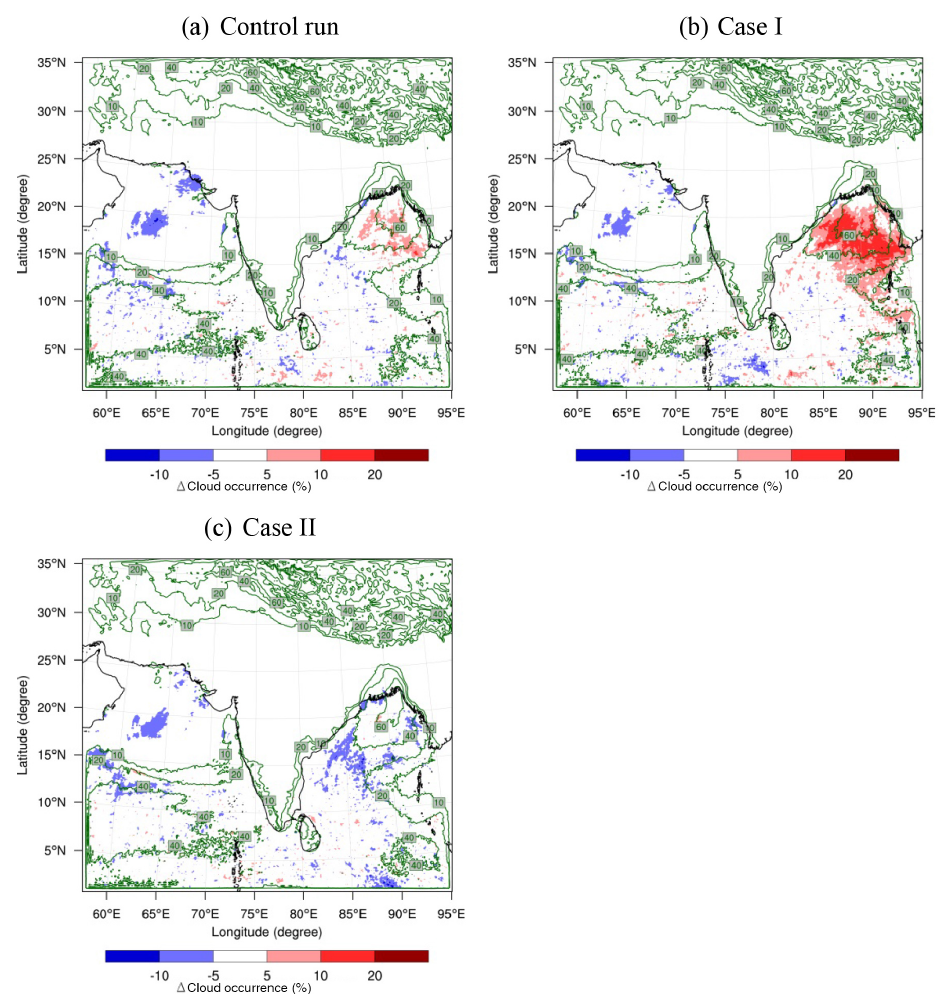
Figure 7. Changes in frequency of cloud occurrence (defined as percent of hours in a month with clouds below 500hPa in each column) due to aerosols for (a) the control run, (b) Case I, and (c) Case II. The contour lines in green in each panel indicate calculated frequency of cloud occurrence without aerosols. The contour levels are shown for 10, 20, 40, and